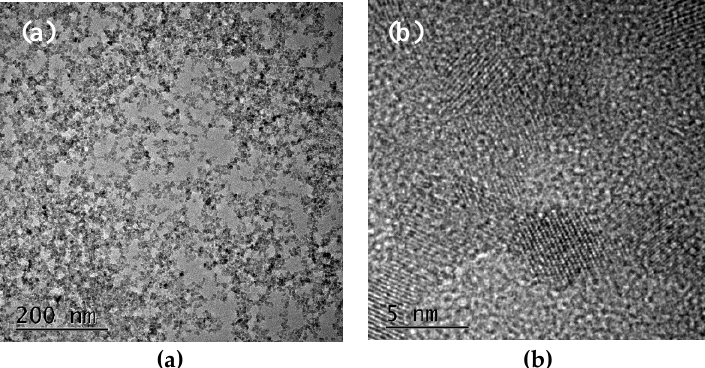
Figure 1. Transmission electron microscope (TEM) images of TiO 2 nanoparticles: ( a ) The low magnification; ( b ) The high magnification.